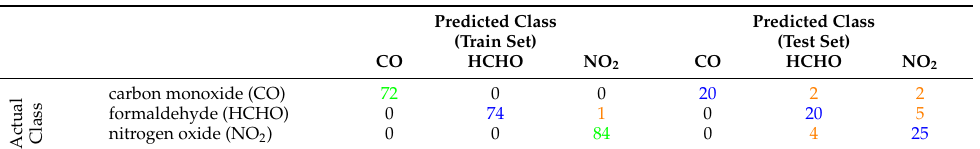
Table 14. Confusion matrix for the UMAP-ELM training and test sets for dataset #3 (for the ELM activation function tanh).